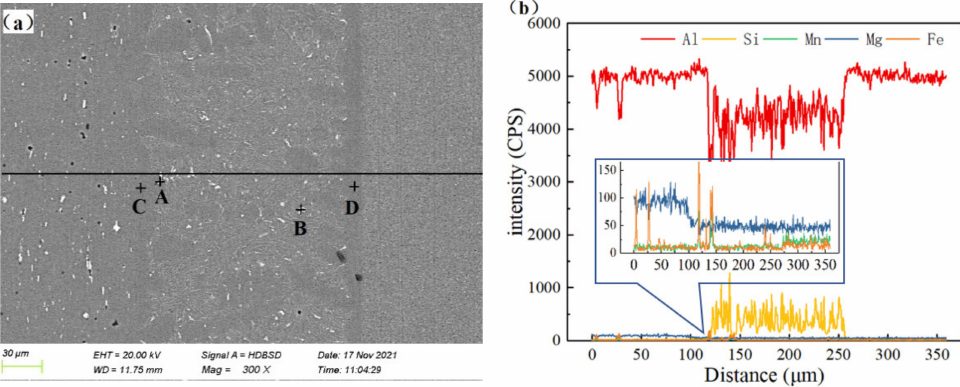
Figure 10. Element diffusion and interface conditions of the PM brazed joint: ( a ) Microstructure of the PM brazed joint; ( b ) The distribution of line scan elements in Figure